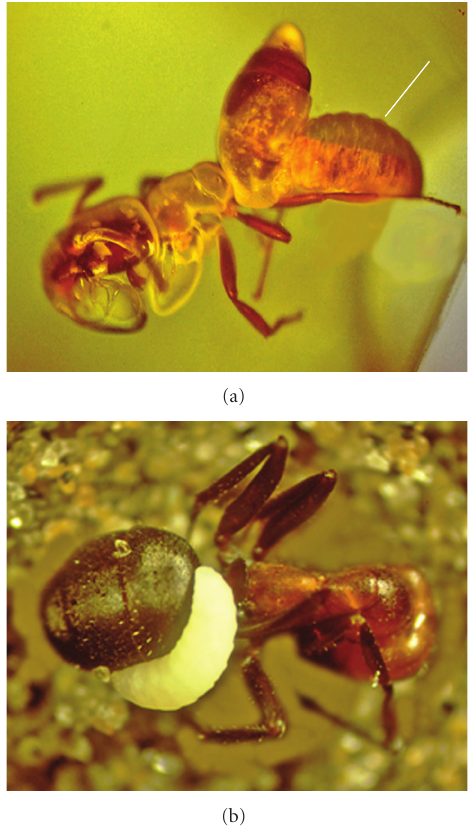
Figure 4: (a) Elasmosomites primordialis larva (white pointer) emerging from the abdomen of a Lasius worker in Baltic amber. Photo courtesy of G. Poinar Jr. (see [136]). ( b) Elasmosoma michaeli larva leaving its Formica obscuriventris clivia host to pupate in the soil. Photo courtesy of G. Poinar